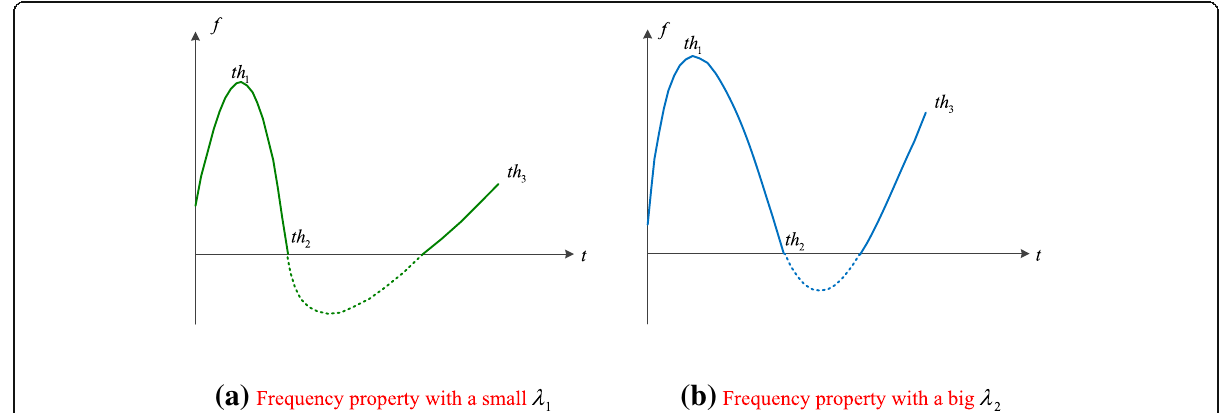
Fig. 4 Frequency band change with different coefficient. The frequency variation accounting for different ST domains is illustrated in Fig.